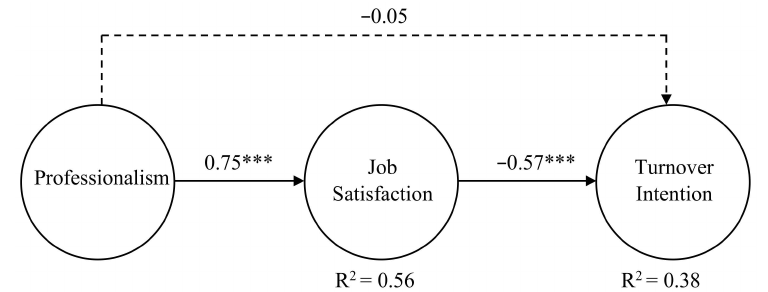
Figure 2. Overall model. Note: *** p < 0.001.